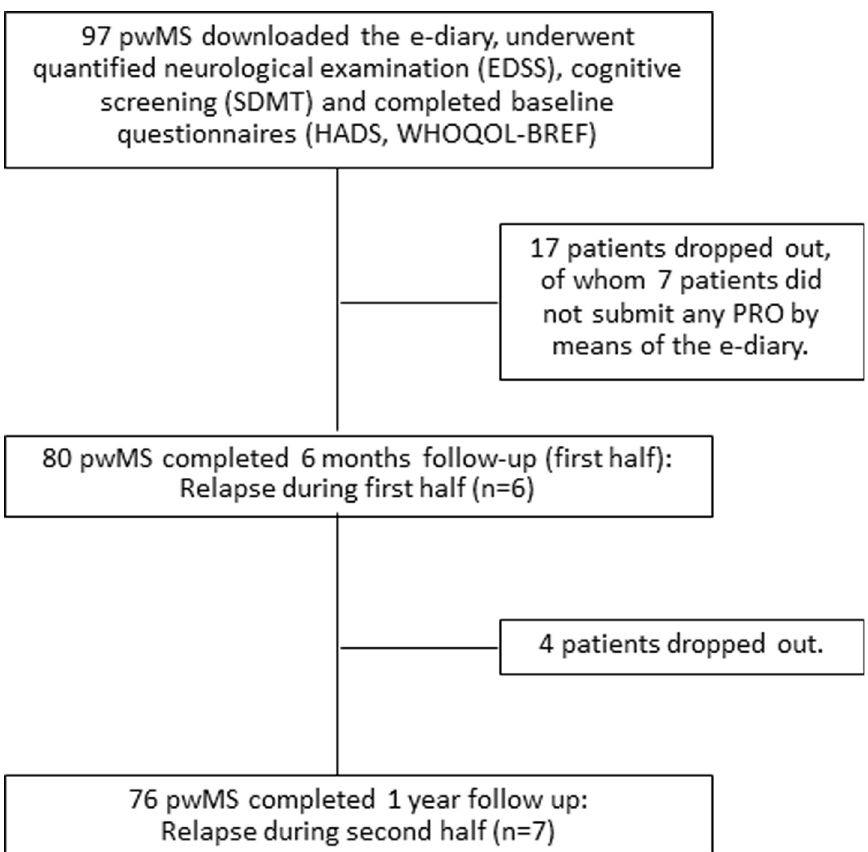
Fig 2. Study flow chart. 21 patients dropped out before 12 months of intended follow up. EDSS = Expanded Disability Status Scale. SDMT = Symbol Digit Modalities Test. HADS = Hospital Anxiety and Depression Scale. WHOQOL-BREF = World health organization quality of life questionnaire. pwMS = people with multiple sclerosis.